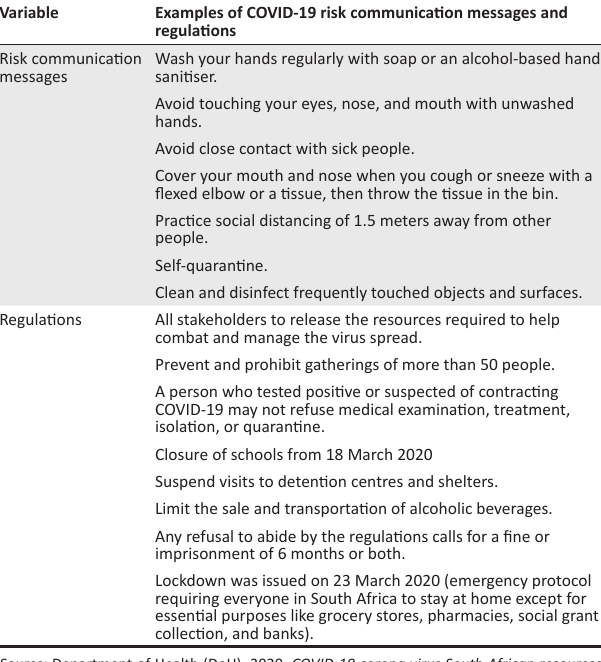
TABLE 1: South African risk communication messages and regulations. Variable Examples of COVID-19 risk communication messages and regulations Risk communication